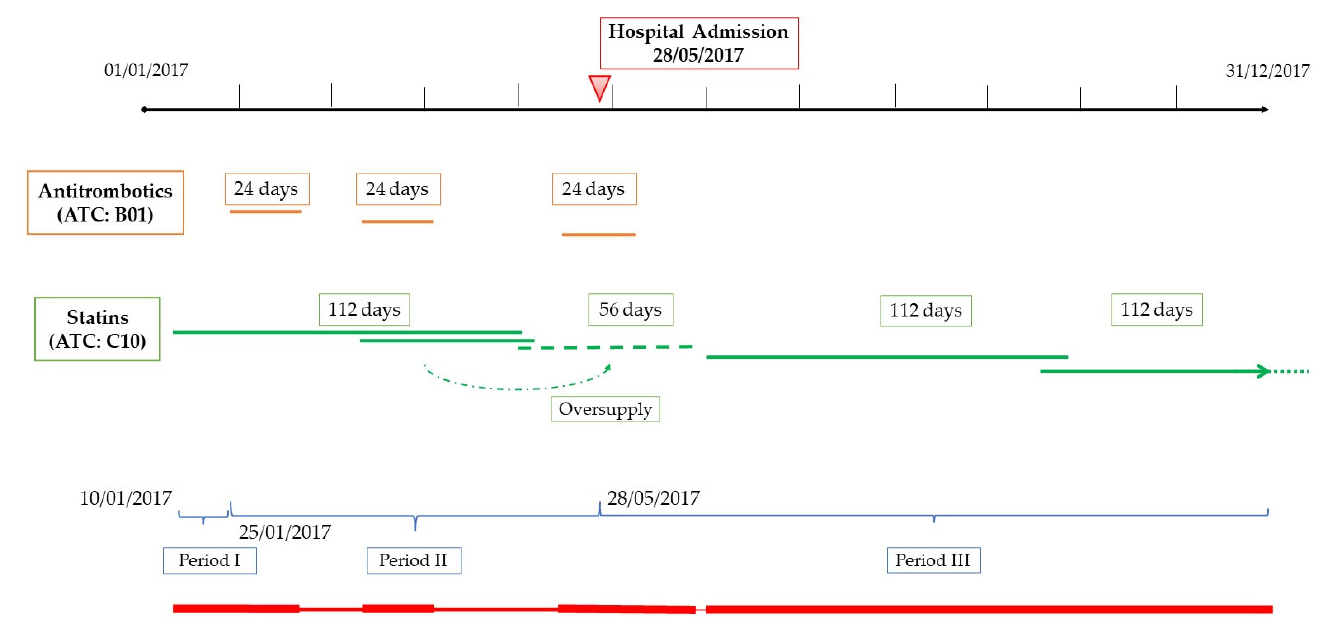
Figure 1. Illustrative example of the calculation of the proportion of days covered (PDC) and of the daily polypharmacy possession ratio (DPPR) for a patient prescribed with 2 medications, with 7 dispensations. The first drug was dispensed as follows: 25/01, 10/03, and 15/05 for 24 days coverage each; the second drug was dispensed as follows: 10/01 for 112 days coverage, 10/03 for 56 days coverage, 01/07, and 18/10 for 112 days coverage each. During a hospital stay on 28 May 2017, the first drug was discontinued. The dashed line indicates the carryover of excess medication from one interval to the next interval. The bottom red line indicates the DPPR daily score (the thickness is proportional to the proportion of medications available on each day: dark, 1/1 or 2/2; medium, ½; light, 0). Calculation: PDC for antithrombotics (B01): (24 + 24 + 13)/123 = 0.496 (49.6%); PDC for statins (C10): (112 + 56 + 112 + 71)/355 = 0.989 (98.9%); DPPR = [15*1 + (24*2/2 + 22*1/2 + 24*2/2 + 40*1/2 + 13*2/2) + (30*1 + 0*4 + 183*1)]/355 = 0.901 (90.1%).